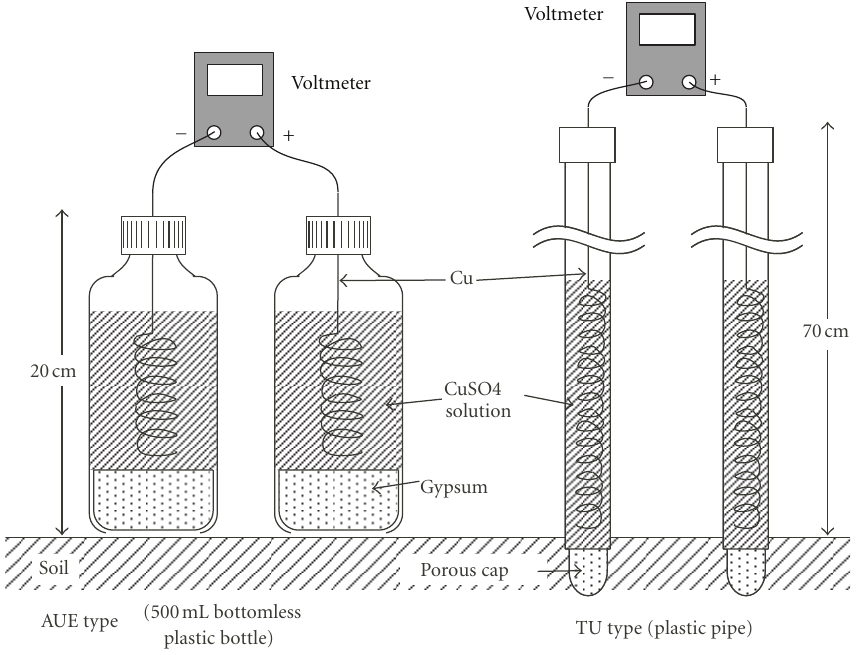
Figure 2: Schematic diagram of Cu-CuSO 4 electrodes used in this